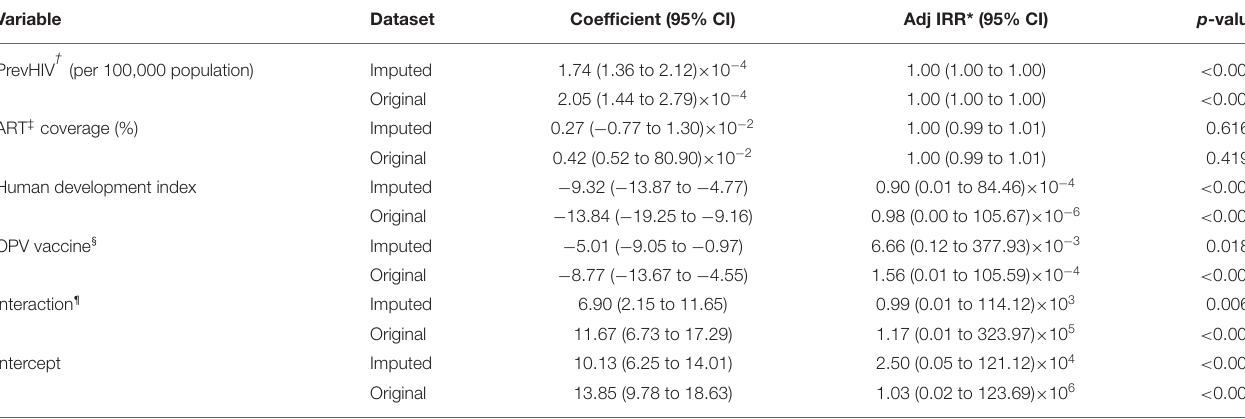
TABLE 2 | Pooled results of negative binomial regression obtained from the analysis of 5 imputed datasets and the original